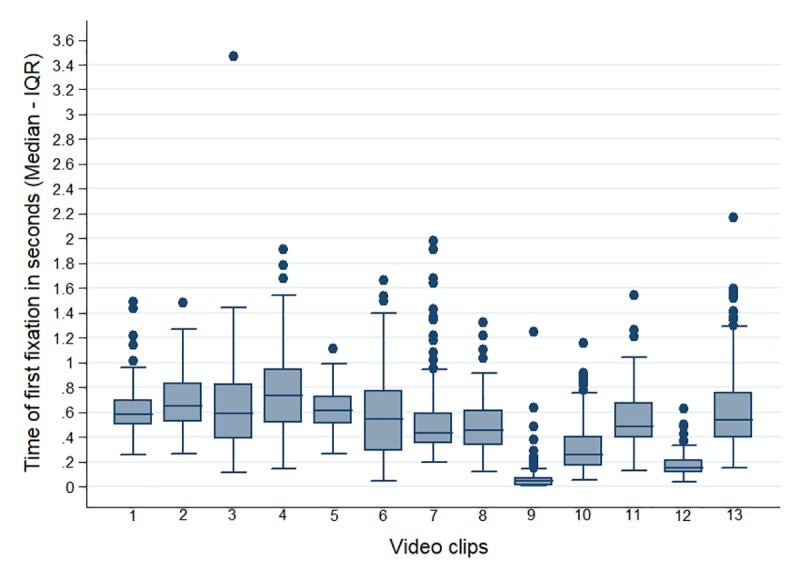
Time to first fixation (in seconds) in areas of interest (Median—(IQR)).